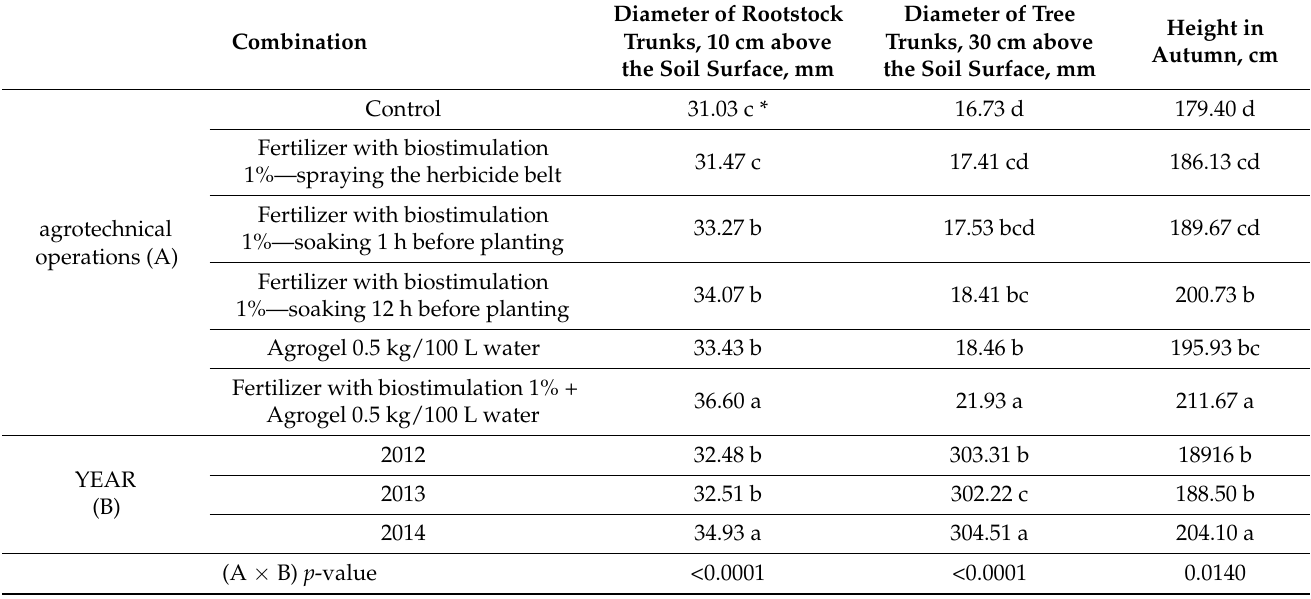
Table 1. Impact of agrotechnical operations on the diameter of rootstock and tree trunks and height in autumn after growth. Diameter of Rootstock Combination Trunks, 10 cm